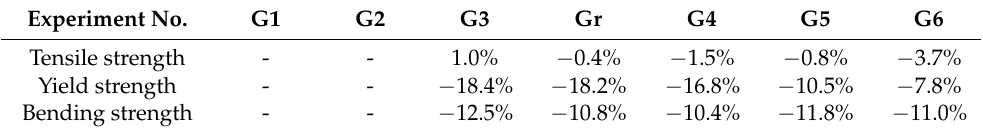
Figure 9. The relationship between mechanical properties and test time in laboratory accelerated conditions: ( a ) tensile strength; ( b ) yield strength; ( c ) bending strength. Table 7. Loss of strength in laboratory accelerated corrosion test after 32 weeks.